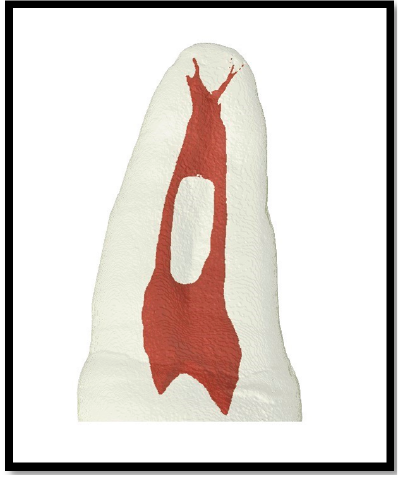
Figure 10. Micro-CT image showing the additional canal configuration (2-1-2-1).